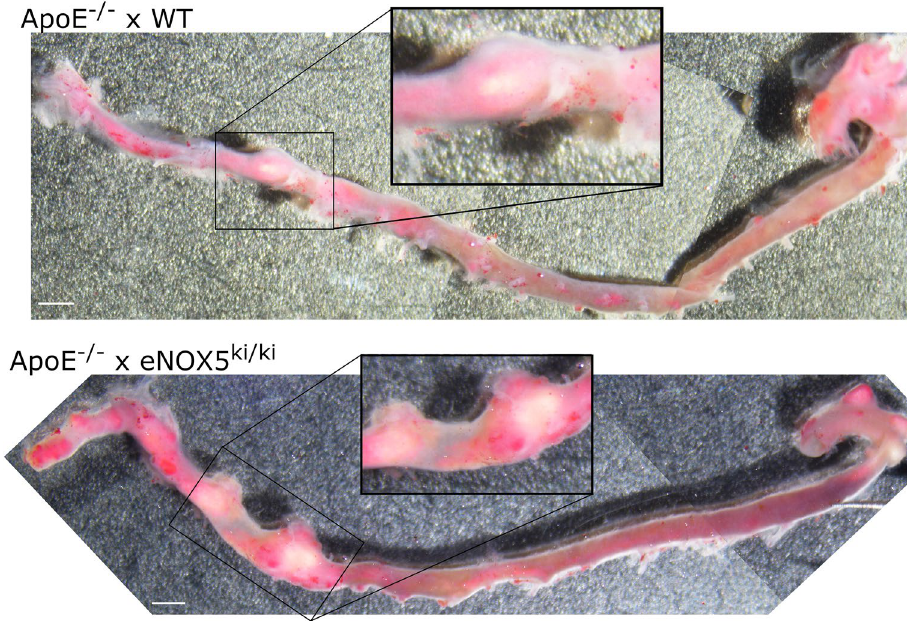
Figure 3. Whole mount examples of sudan IV stained aortas of diabetic ApoE −/− mice with and without endothelial NOX5 expression. Bars (white, at bottom left) indicate 1 mm.